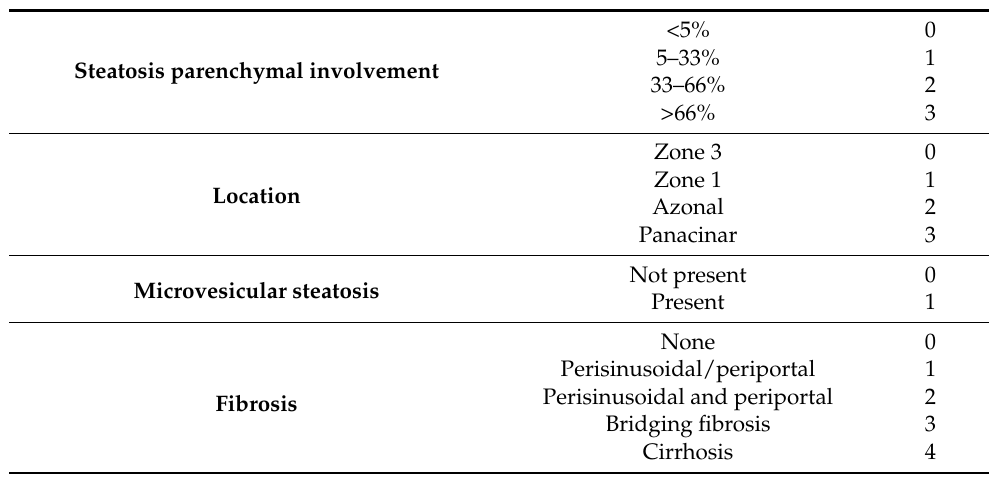
Table 1. Scoring system used for quantification of fatty liver